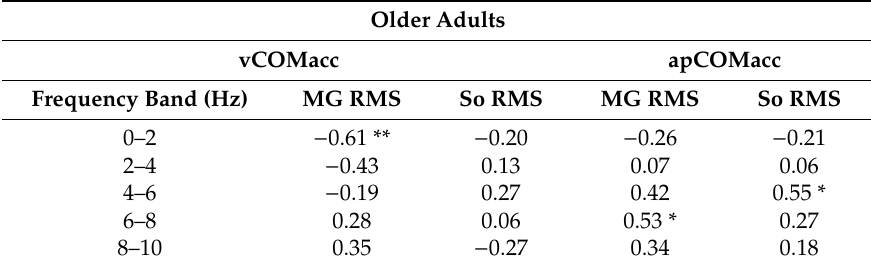
Table 4. Correlation between the power spectral density of vCOMacc or apCOMacc in older adults and the root mean square of lower limb muscle activity. Older